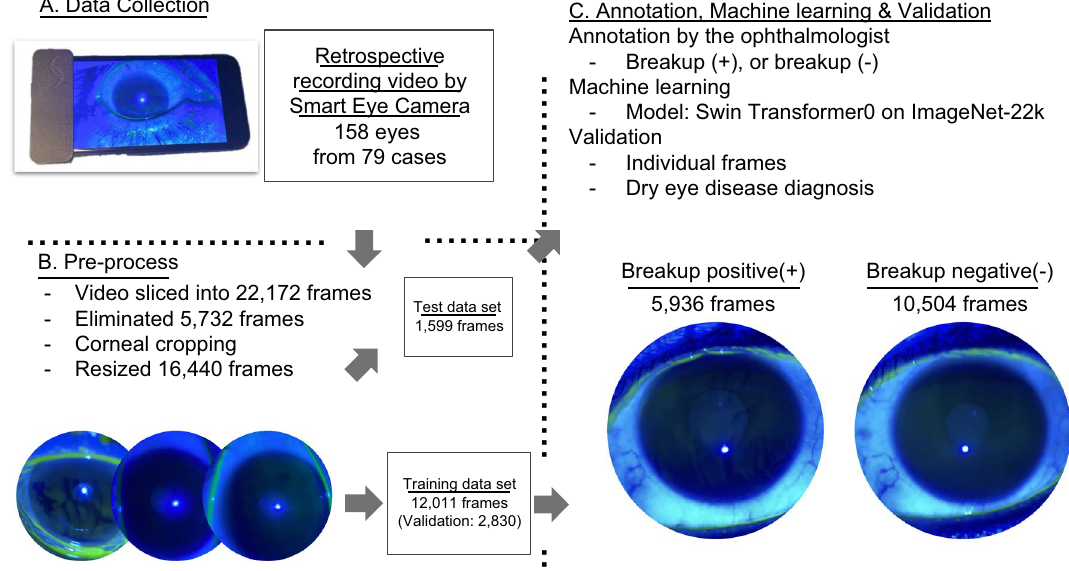
Figure 1. The study flowchart. ( A ) Data collection using a recordable slit-lamp device called Smart Eye Camera. Data regarding 158 eyes from 79 cases were collected. ( B ) Pre-processing before machine learning. The video was sliced into frames of 0.2-ms intervals and organized into 22,172 frames. A total of 5732 frames were eliminated as they were not focused on the ocular surface and due to noise (eyelashes, light reflex), which impeded the model from learning. The remaining 16,440 frames were resized into 384 × 384 pixels. Annotation and machine learning process. Sorting of frames: 90% of the data were assigned to the training dataset, and the remaining 10% were assigned to test dataset. A DED specialist annotated all of the frames randomly and classified them into “breakup positive(+)” or “breakup